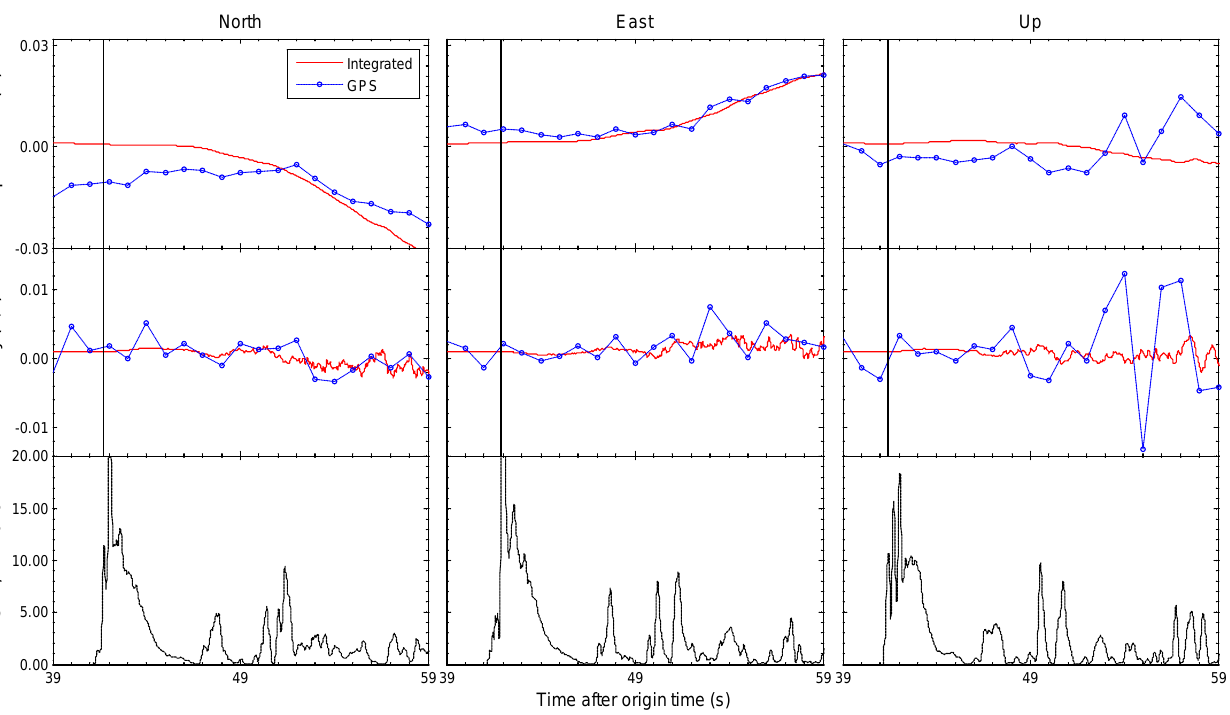
Figure 6. An enlarged view of the first 20 s of the coseismic displacements and velocities in all three components on the collocated AKT006 (seismic) and 0183 (GPS) stations during the Tohoku-oki earthquake on 11 March 2011. The 1 Hz GPS-only and 100 Hz tightly-integrated displacements and velocities are respectively shown by the blue dotted lines and red lines. The bottom sub-figures are STA/LTA ratio results based on tightly-integrated results, which show the first arrival time of seismic wave. The sub-figures show, from left to right, the north, east and up